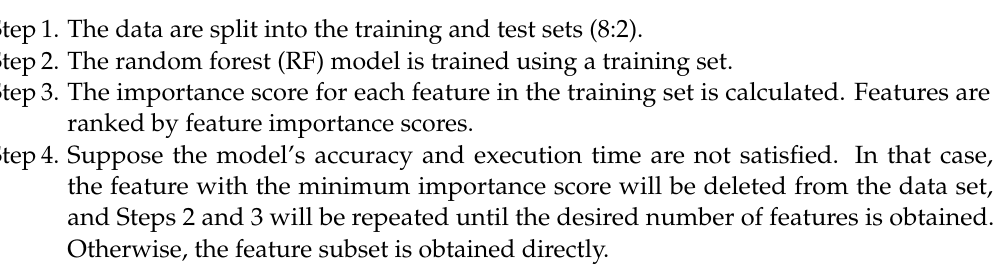
Figure 6. Flow chart of the prediction models.